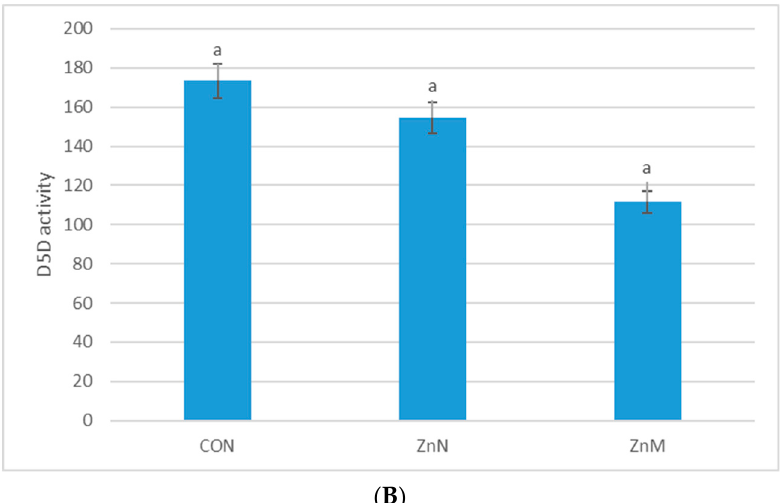
Figure 3. Activities of D6D ( A ) and D5D ( B ) in the serum of experimental groups. CON—control group; ZnN—group receiving zinc in nanoparticles; ZnM—group receiving zinc in microparticles. a,b —homogenous groups ( α = 0.05), D6D– Δ 6-desaturase index, D5D– Δ 5-desaturase index.